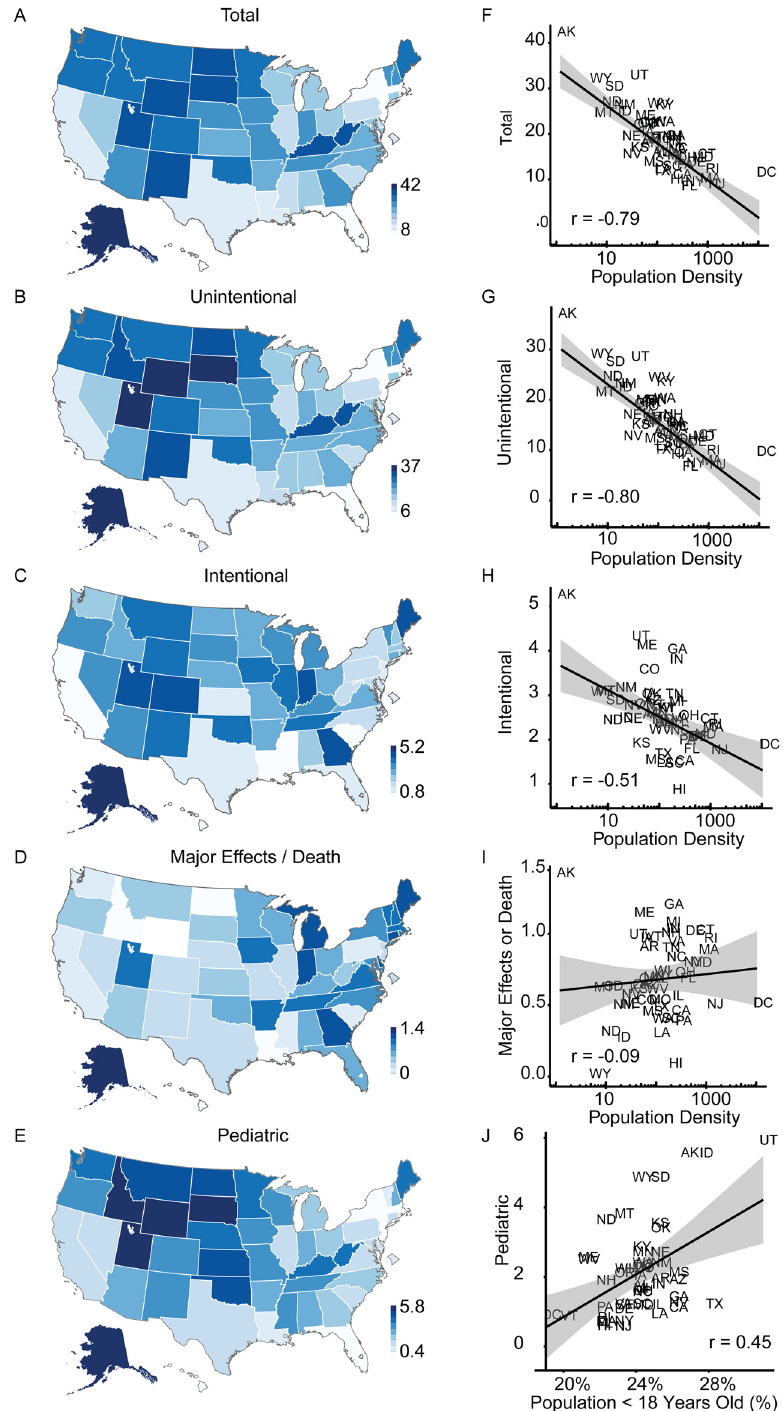
Fig 2. Incidence proportion of ethylene glycol exposures and population correlations. Choropleth maps show incidence proportion for ethylene glycol exposures for (A) all, (B) intentional, (C) unintentional, (D) major effects and death and (E) pediatric unintentional exposures ( (cid:1) 6 years old). Panels F-J show corresponding state incidence proportions correlated with population density (population per square mile) by state (F-H), panel J shows incidence of pediatric unintentional exposures correlated to percent of population of children under 18 years old by state. Incidence is per 100 000 humans, r = Pearson ’ s correlation coefficient.